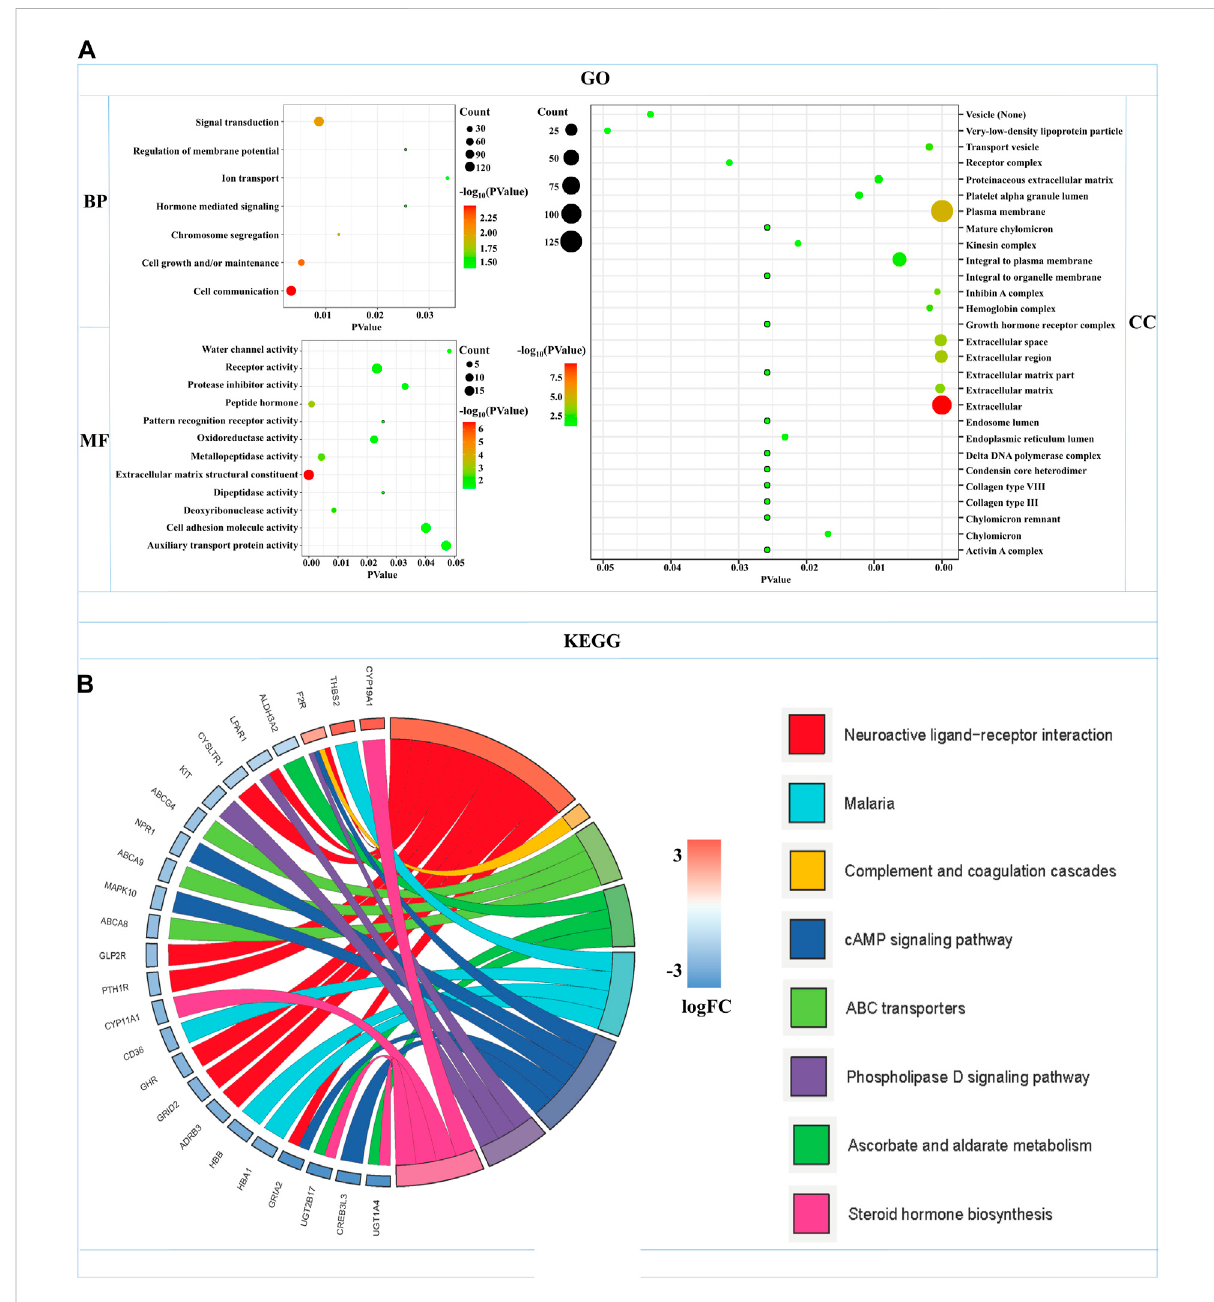
FIGURE 5 Functional enrichments of mRNAs-OS in overall-stage STAD. (A) GO function annotations (including BP, CC, and MF). The abscissa represents the p -value, and the ordinate represents the name of the functions. The bubble area increases with the number of mRNA-OS increasing. (B) KEGG pathways analysis. The color of the columns changes from blue to red as the degree of mRNAs enriched in the pathways